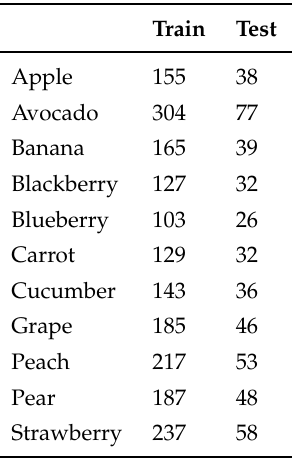
Table 7. Train and validation images per